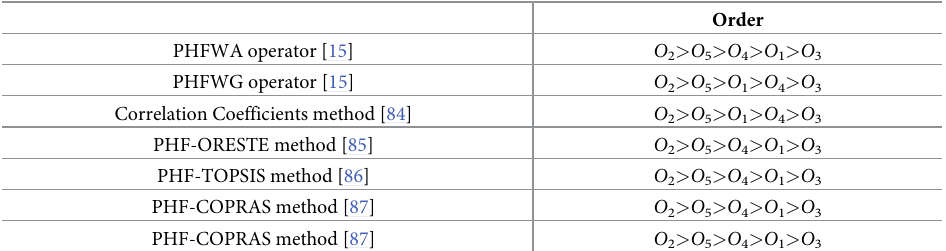
Table 29. Order of different